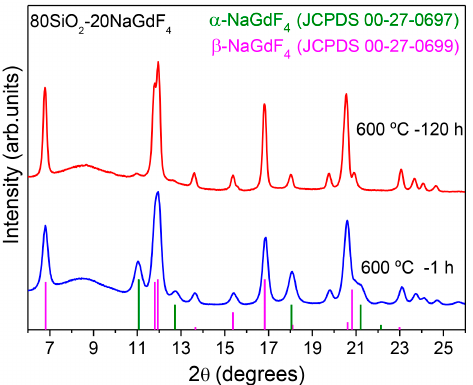
Figure 16. XRD of 80SiO 2 -20NaGdF 4 GC treated at 600 °C for 1 and 120 h. The measurements were performed at the synchrotron SpLine BM25 of the ESRF.